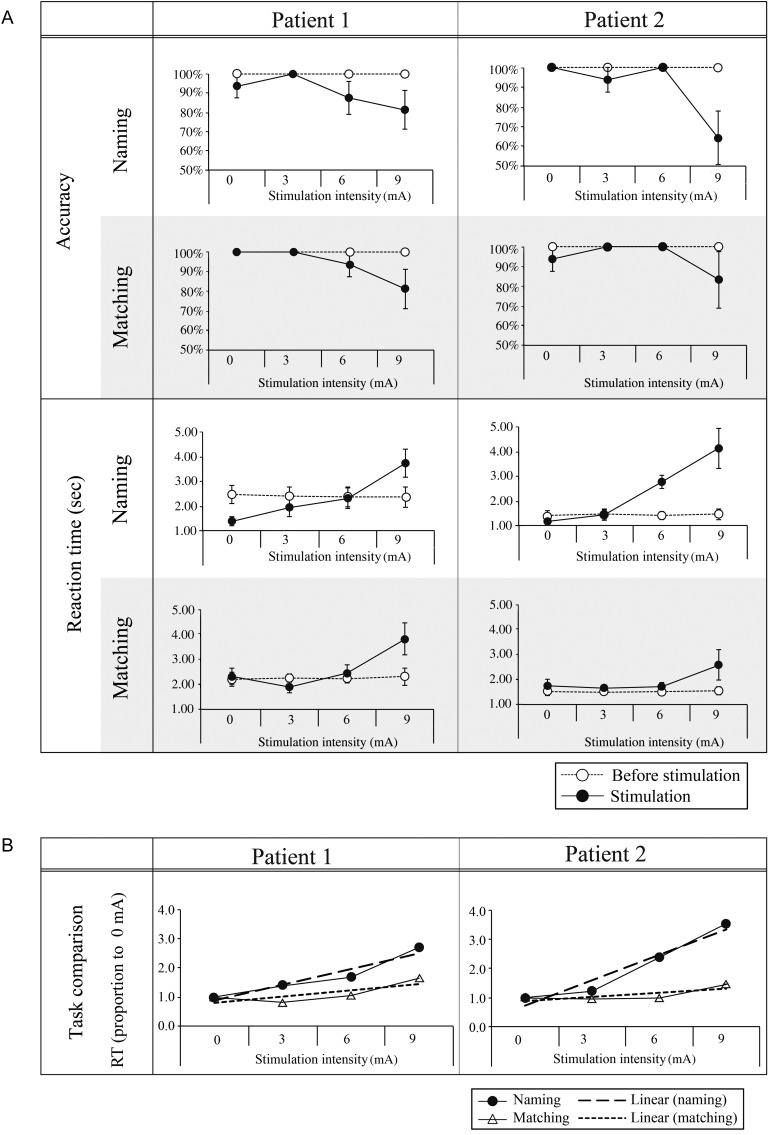
Effect of varying anterior fusiform stimulation intensity on naming and written word-picture matching performance. (A) The direct comparison of performance before and after stimulation for the 2 tasks in Patients 1 and 2. The same pattern was observed in both RT and accuracy, though RT was more sensitive overall to the effect of milder stimulation intensities (see the main text). As expected, performance declined (slower RTs and lower accuracy) as stimulation intensity increased. (B) A direct comparison (by normalization to the sham condition—see Experimental Procedures) of the relative effect of stimulation intensity on the 2 tasks for both patients. As expected, stimulation had a relatively greater impact on naming than word-picture matching (see the main text).